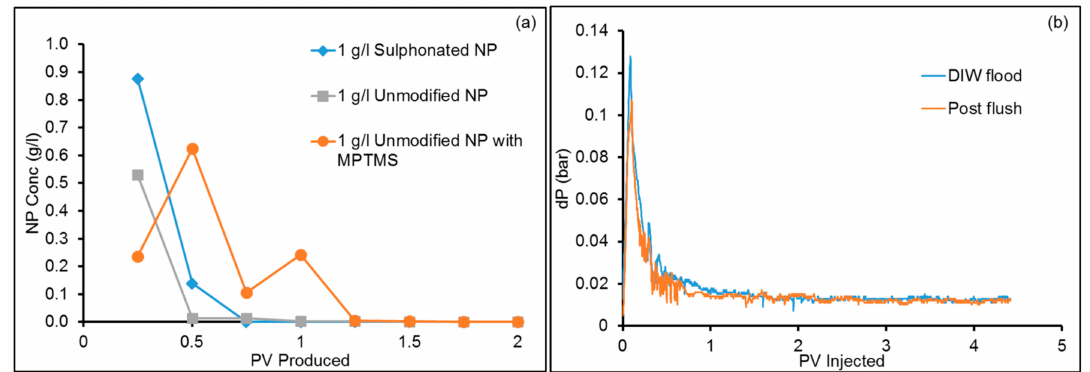
Figure 10. ( a ) Comparison of effluent concentration profiles of the different types of nanofluid (concentration of NP: 1 g/L) silica, sulfonated and silica with stabilizing fluid; ( b ) Pressure drop profiles for core treated with sulfonated